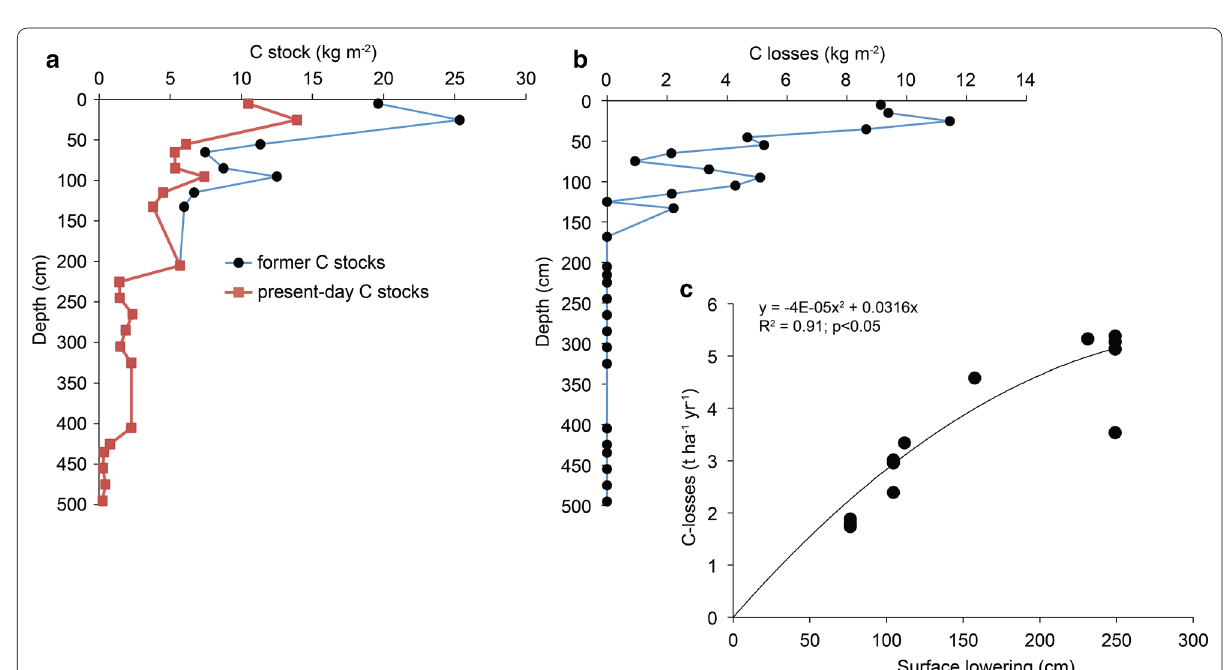
Fig. 7 a Present-day carbon stocks at profile 1 compared with the former stocks (prior to the Swiss Jura Water corrections), b calculated C-losses as a function of profile depth, c correlation between surface lowering and C-losses (all investigated